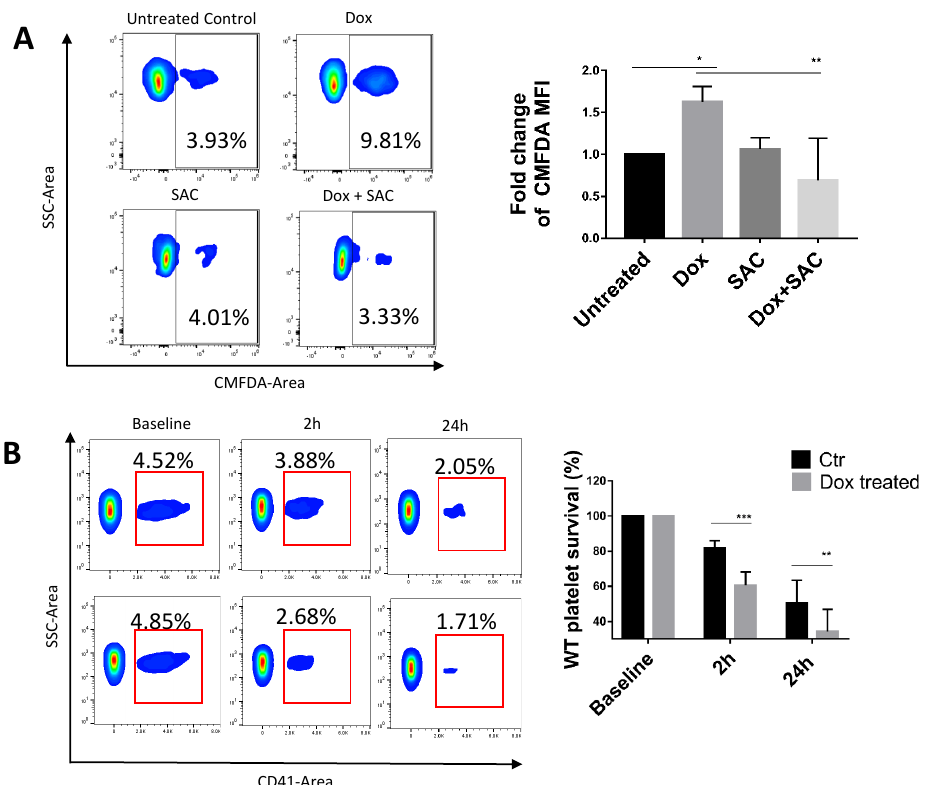
Figure 3. SAC Reduces Platelet Phagocytosis by THP-1 Macrophages. ( A ) Dox increased human platelet phagocytosis by differentiated THP-1 macrophages. Platelets were stained with CMFDA and then co-incubated with differentiated THP-1 cells and 40 µ g/mL Dox pretreated with or without SAC (40 µ M). THP-1 cells were washed to remove platelets and analyzed for CMFDA signal by flow cytometry. ( B ) Effect of Dox in ex vivo platelet transfusion survival assay. Platelets from WT mice were treated with 40 µ g/mL Dox prior to transfusion into CD41 − / − mice. Blood samples were taken from recipient mice at 0, 2, and 24 h after transfusion, and platelets were stained for CD41 to determine surviving percentage of transfused platelets. Data displayed as mean ± SD.